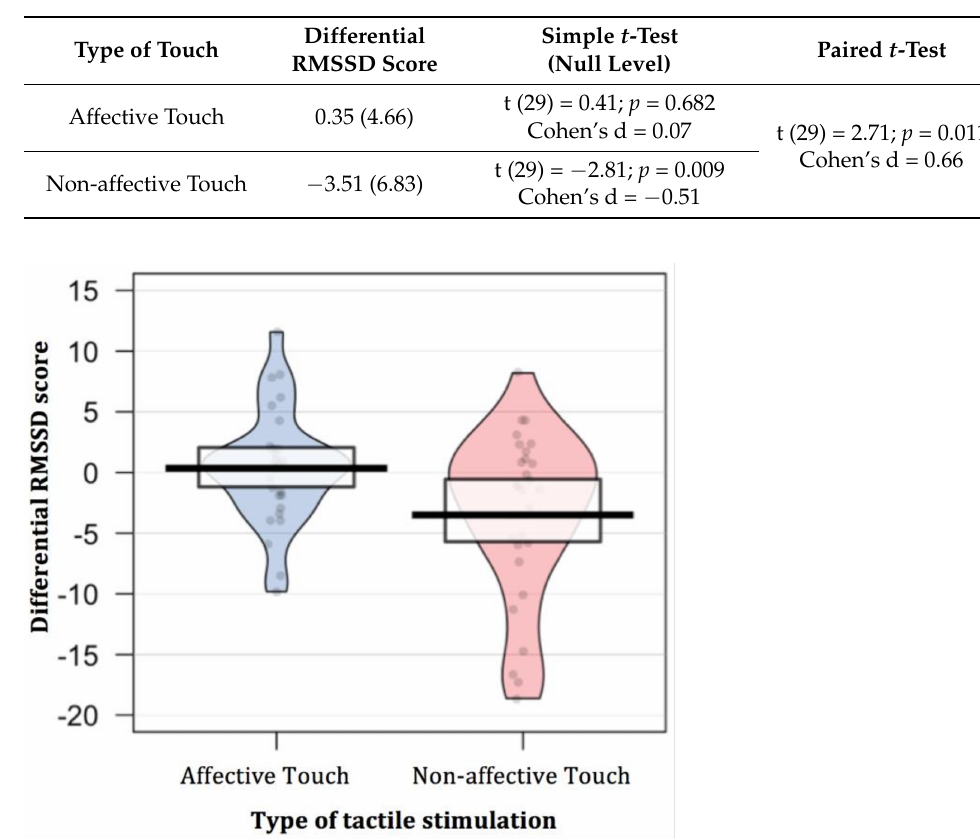
Table 1. Descriptive statistics for each type of tactile stimulation (mean and standard deviation of the differential RMSSD score); simple t -test comparing the differential RMSSD score with the null level; and paired t -test comparing the differential RMSSD score in response to the two different tactile stimulations (affective touch vs. non-affective touch).